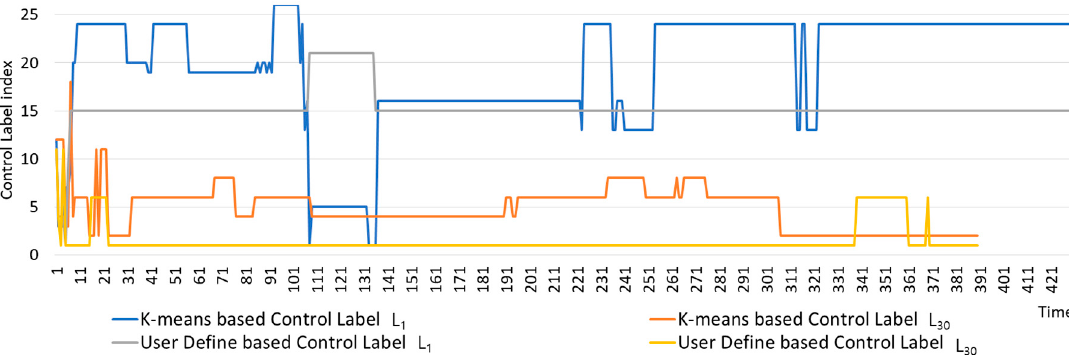
Figure 9. Result of conversion of the first and 30th collected video control signals into control labels.